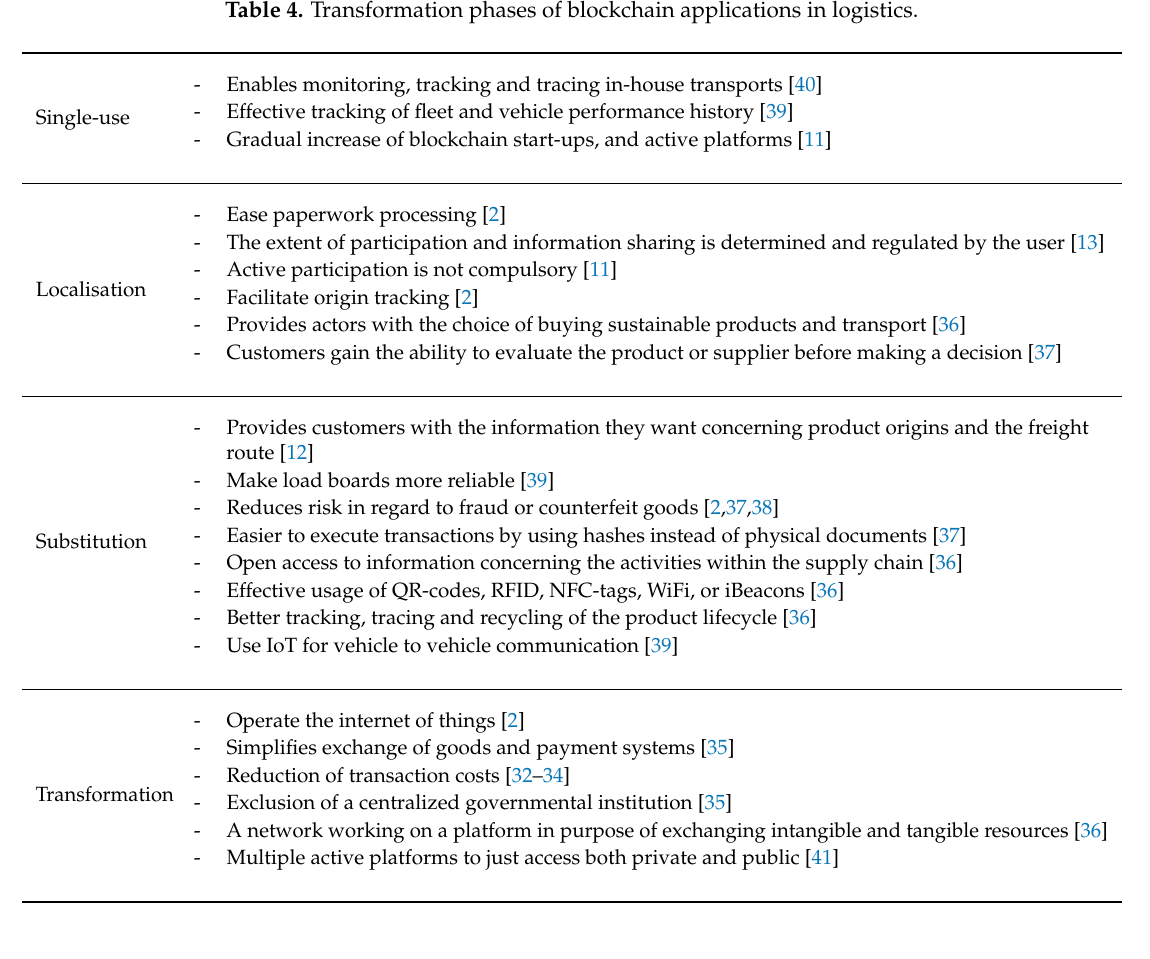
Table 4. Transformation phases of blockchain applications in